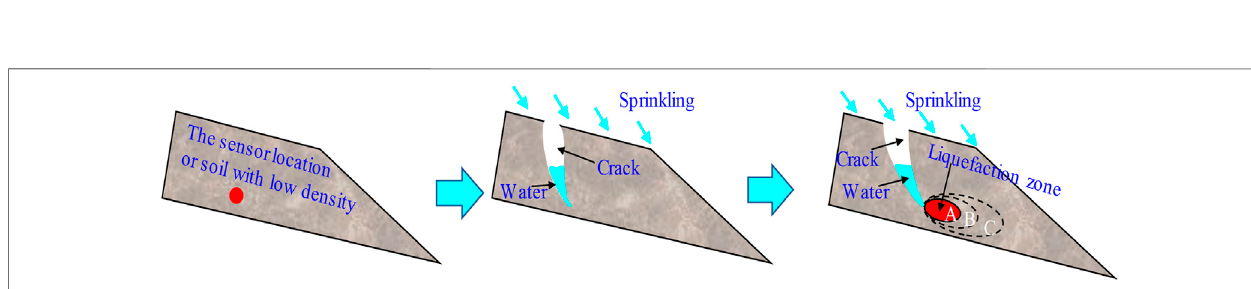
Frontiers in Earth Science |